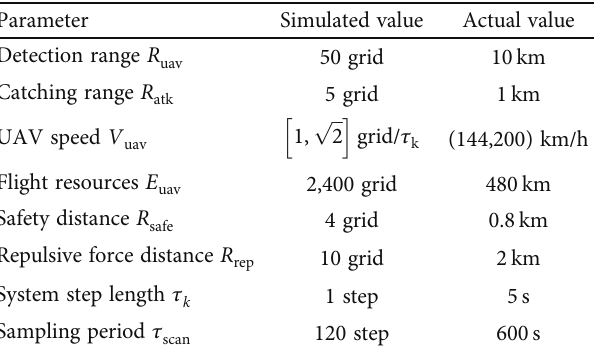
Table 1: Simulation parameters.